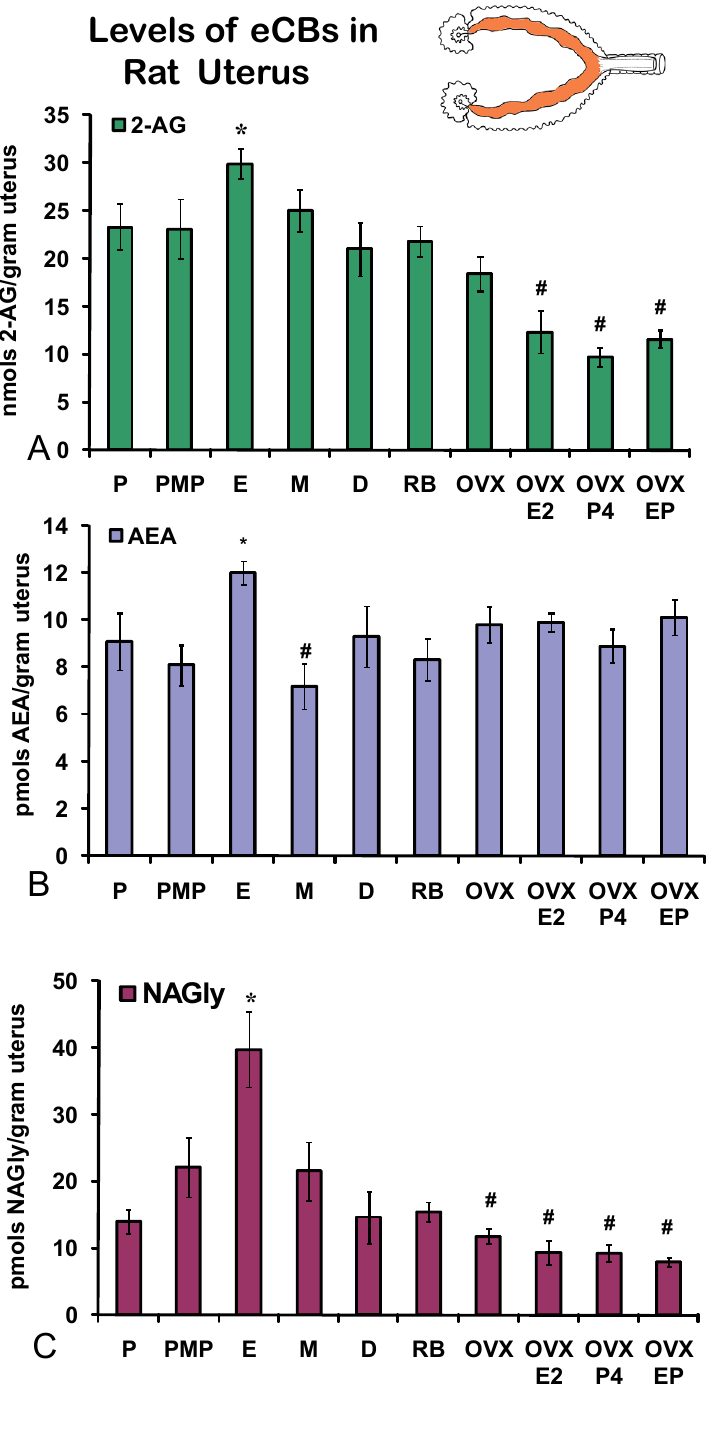
Figure 5. Levels of eCBs in rat uterus across the hormonal cycle, in anovulatory retired breeders (RB), after ovariectomy and hormone replacement. P = proestrus AM; PMP = proestrus PM; E = estrus; M = metestrus, D = diestrus; RB = anovulatory retired breeders; OVX = ovariectomy; E2 = 17 β estradiol; P4 = progesterone. * p ≤ 0.05 and represents comparisons across the hormonal cycle. # p ≤ 0.05 and represents comparisons of hormonal cycle groups with retired breeders and OVX treatment